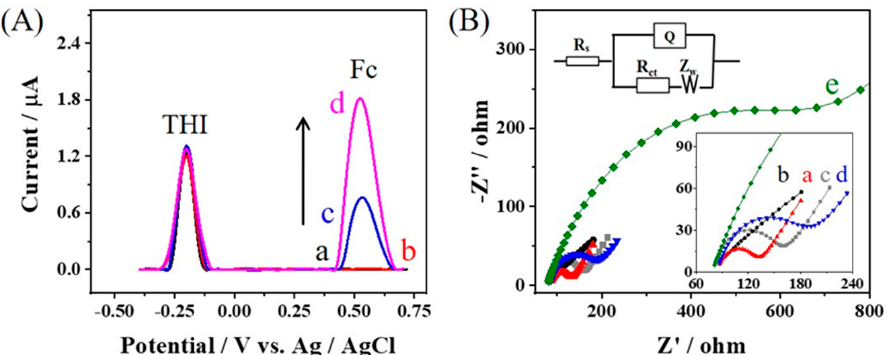
Figure 3. ( A ) ACV characterization of (a) THI-rGO/GCE, (b) CS/THI-rGO/GCE, (c) Fc-Apt-Fc/CS/THI-rGO/GCE, and (d) AFB2 (1 ng mL − 1 )/Fc-Apt-Fc/CS/THI-rGO/GCE. ( B ) Nyquist plots for different electrodes: (a) GCE, (b) THI-rGO/GCE, (c) CS/THI-rGO/GCE, (d) Fc-Apt-Fc/CS/THI-rGO/GCE, and (e) AFB2 (1 ng mL − 1 )/Fc-Apt-Fc/CS/THI-rGO/GCE. Inset is the Randles equivalent circuit used to fit the impedance spectra.